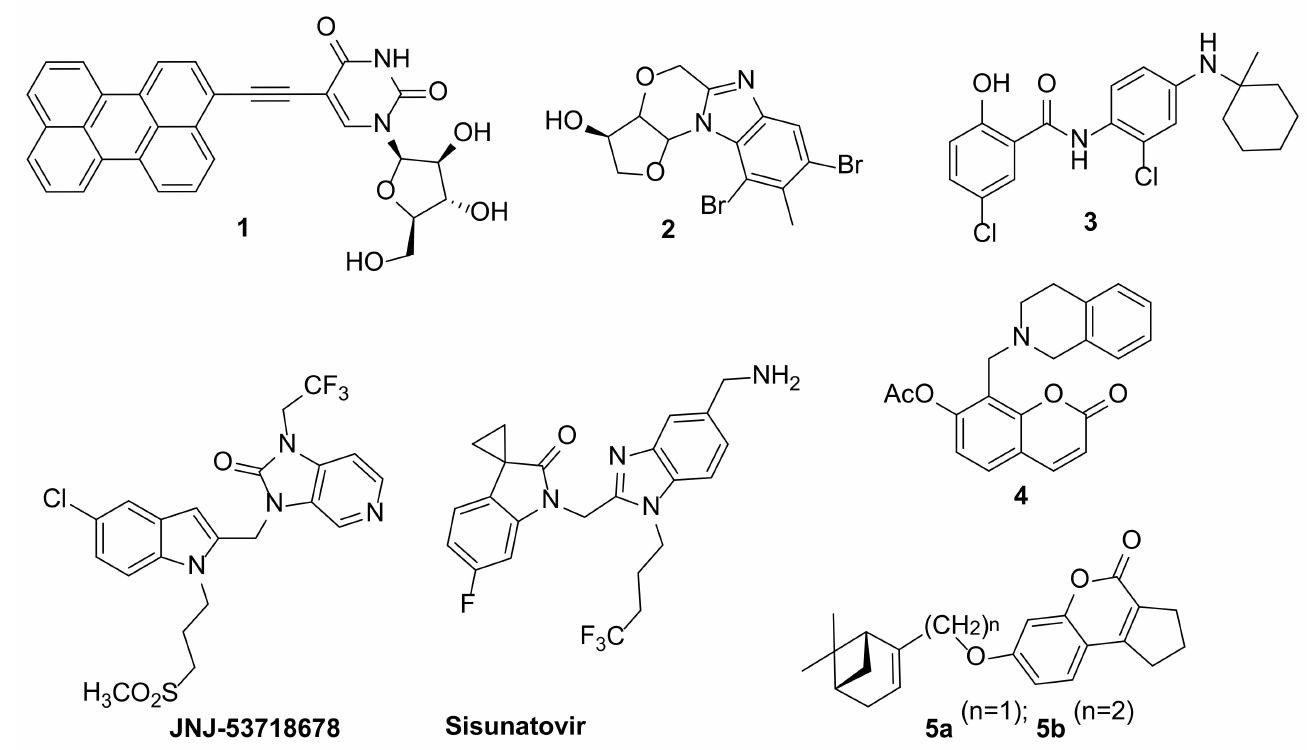
Figure 1. Known compounds with anti-RSV